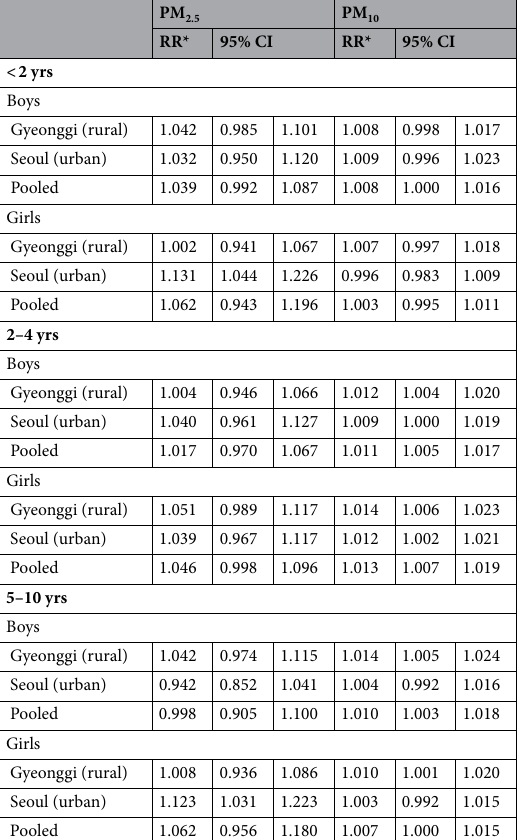
Table 2. Results by sex and age groups using data from two regions Gyeonggi and Seoul. PM 2.5 particulate matter ≤ 2.5 μm/m 3 , RR relative risk, CI confidence interval, yrs years. *Net effect of PM up to 7 days after exposure.